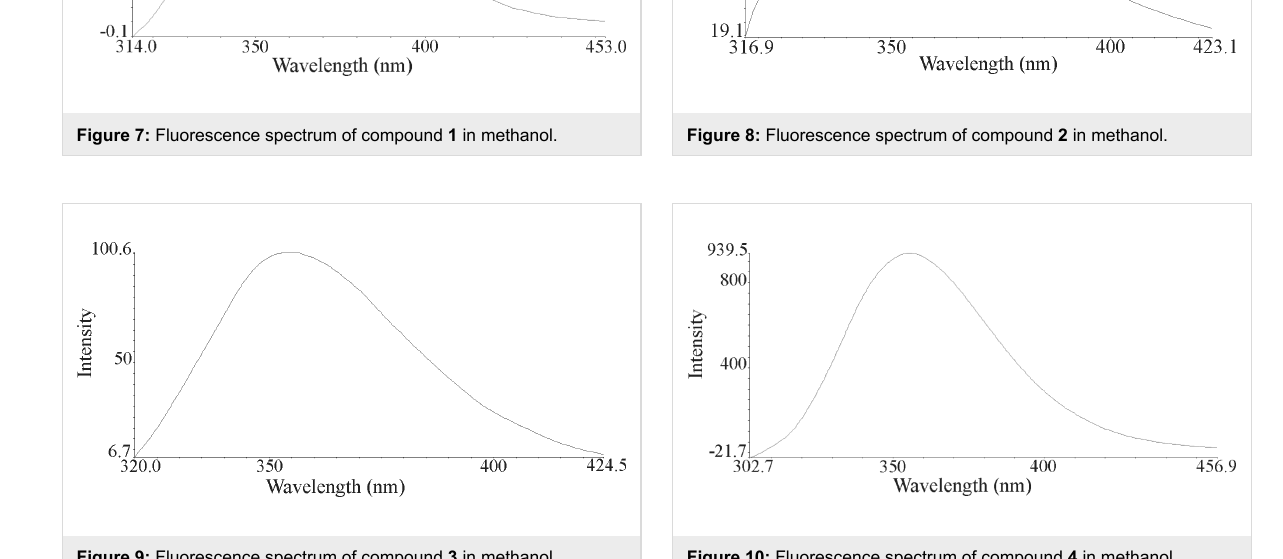
Figure 9: Fluorescence spectrum of compound 3 in methanol.